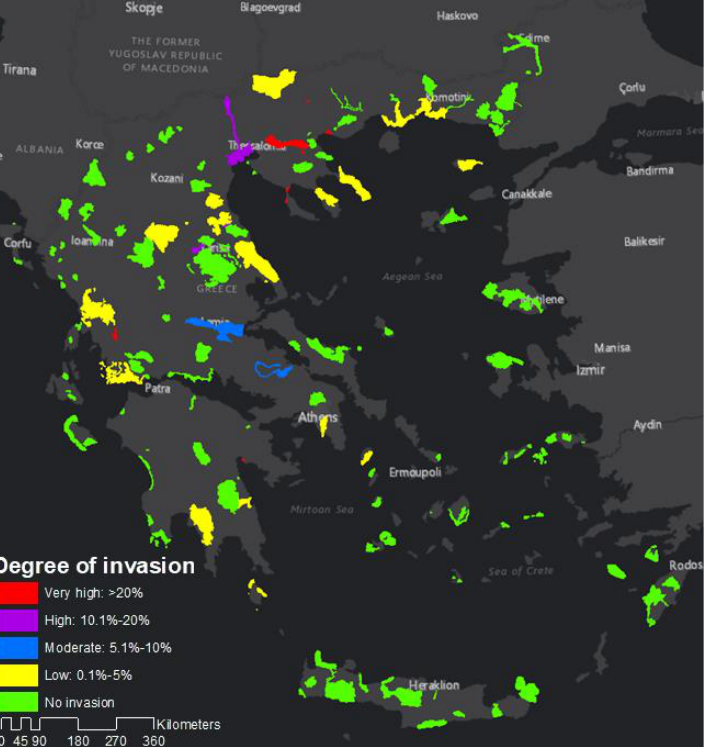
Figure 3. Map of the investigated Greek Natura 2000 sites according to the degree of invasion by Solanum elaeagnifolium . Table 1. Greek Natura 2000 sites invaded by the alien invasive species Solanum elaeagnifolium out- lining the percentage of the site area invaded, the total number of cells invaded, and the number of cells invaded by one or more populations.